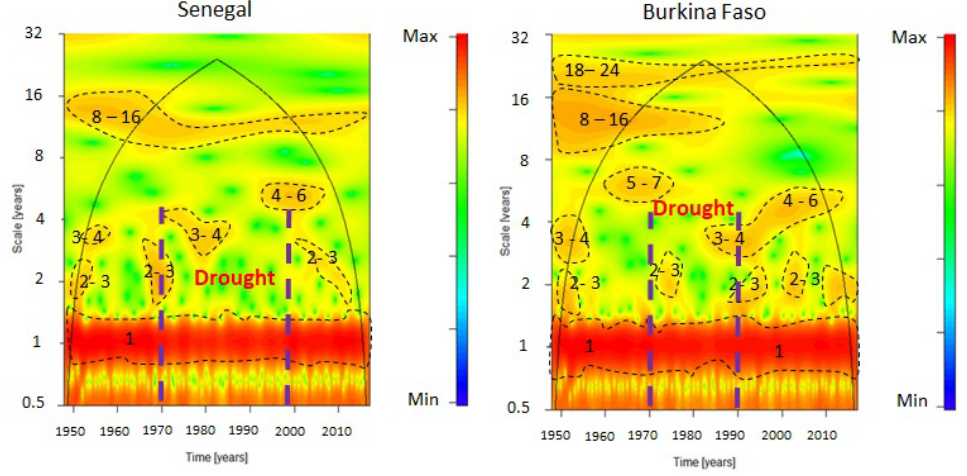
Figure 3. Continuous wavelet of precipitation regime in Senegal and Burkina Faso.